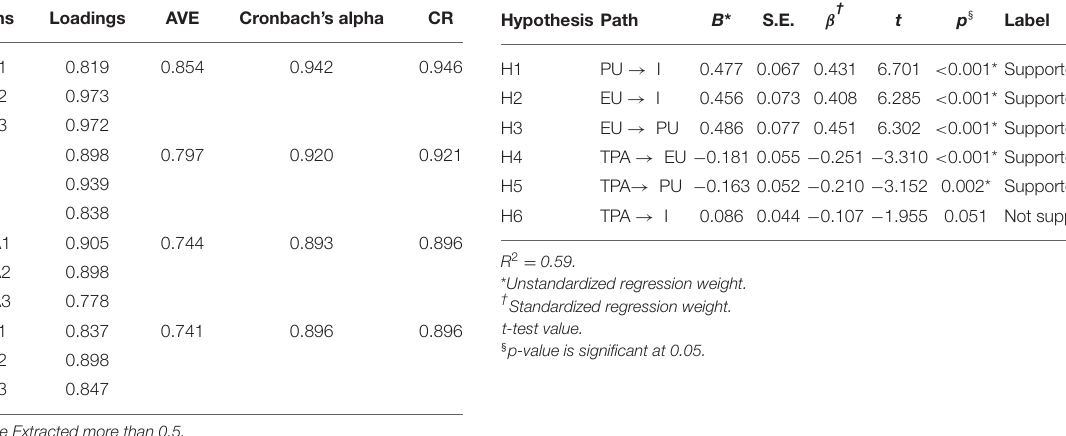
TABLE 4 | Structural model.